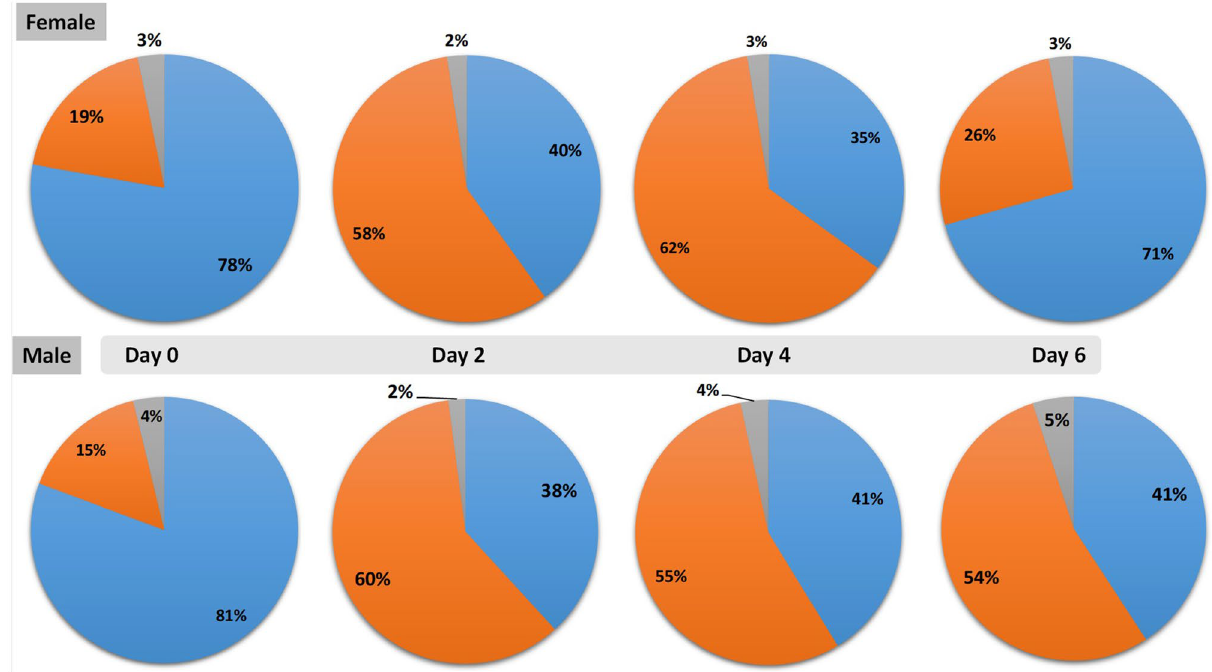
Figure 6. Illustrative effect of expression of the housekeeping (blue), secretory (orange) and unknown (grey) functional classes over time. Expression was measured as TPM ≥ 0.5 for both the male and female